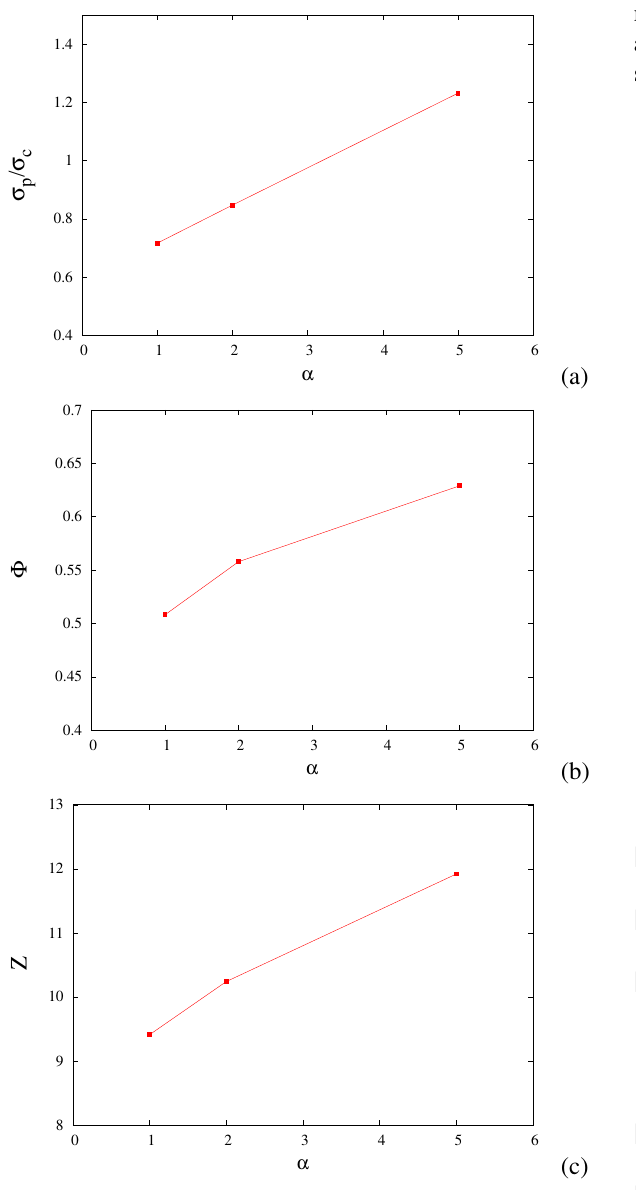
Figure 5. Normalized compressive strength (a), packing fraction Φ (b) and coordination number Z (c) of the granules as a function of size ratio α